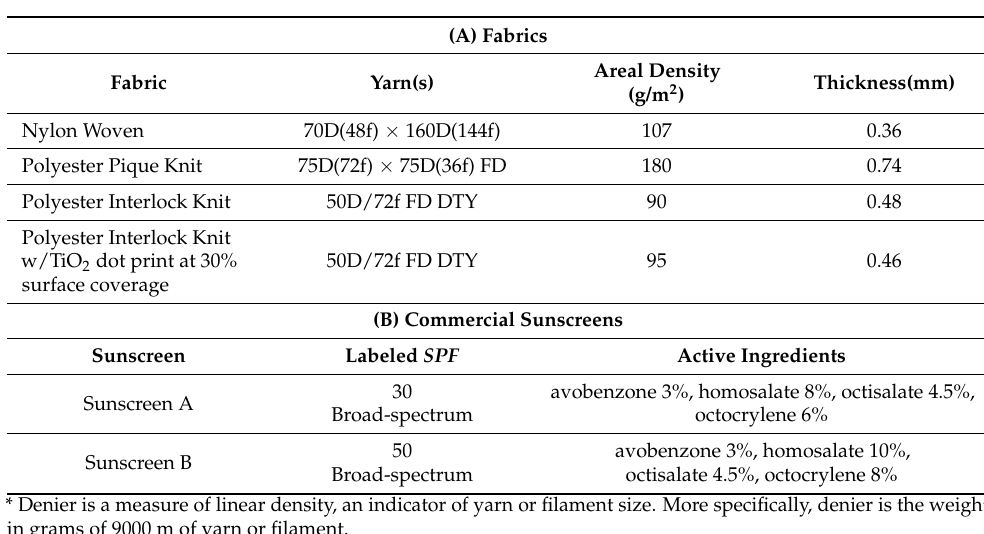
Table 1. Specifications of tested fabrics ( A ) and commercial sunscreens ( B ). FD = fully drawn, DTY = drawn textured yarn, D = denier *, f = filaments. All knit fabrics are 28 gauge.